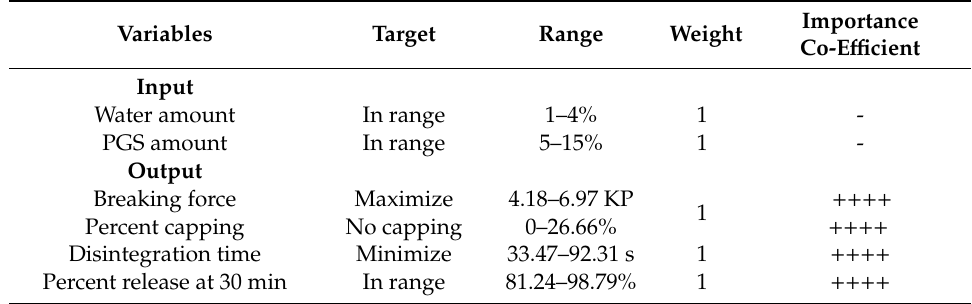
Table 10. The constraints adopted for the optimization of tested variables and estimation of overall desirability.